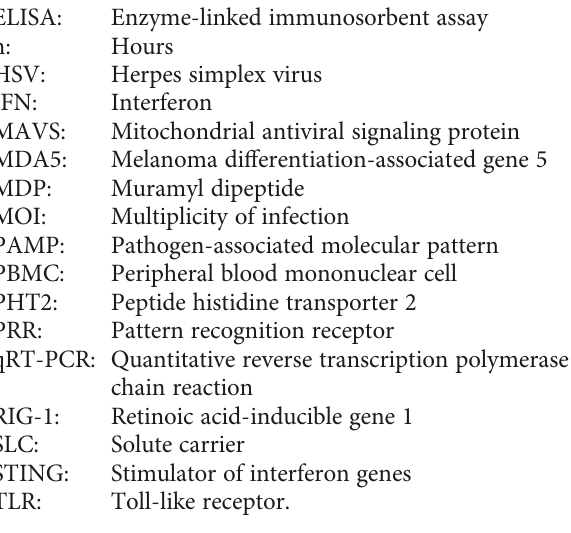
Table S1: siRNA sequences of SLC15A3. Table S2: primer sequences. Table S3: solute carrier genes upregulated by HSV-1 in PBMCs. Figure S1: SLC15A4 gene expression in SLC15A3-silenced cells. (Supplementary